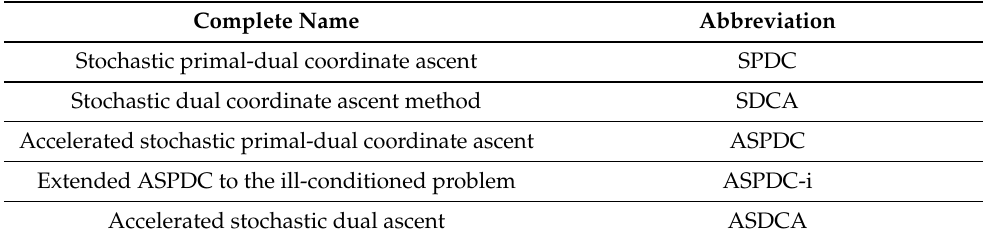
Table 1. Abbreviations used in this